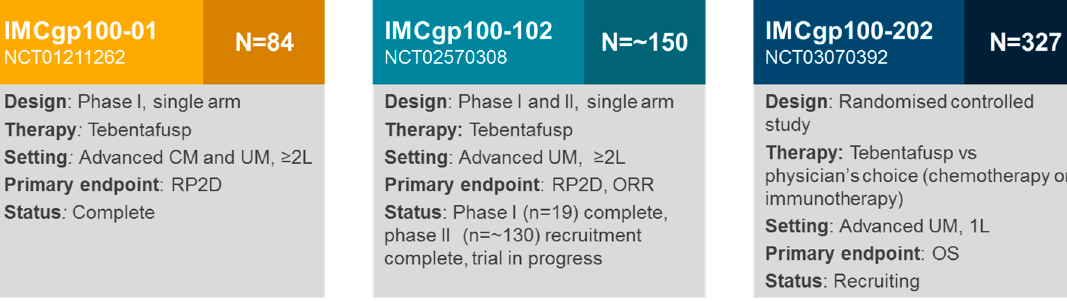
Figure 4. Clinical studies with tebentafusp in UM; 1L, First line; 2L, Second line; CM, Cutaneous melanoma; ORR, Objective response rate; RP2D, Recommended phase II dose; UM, Uveal melanoma.